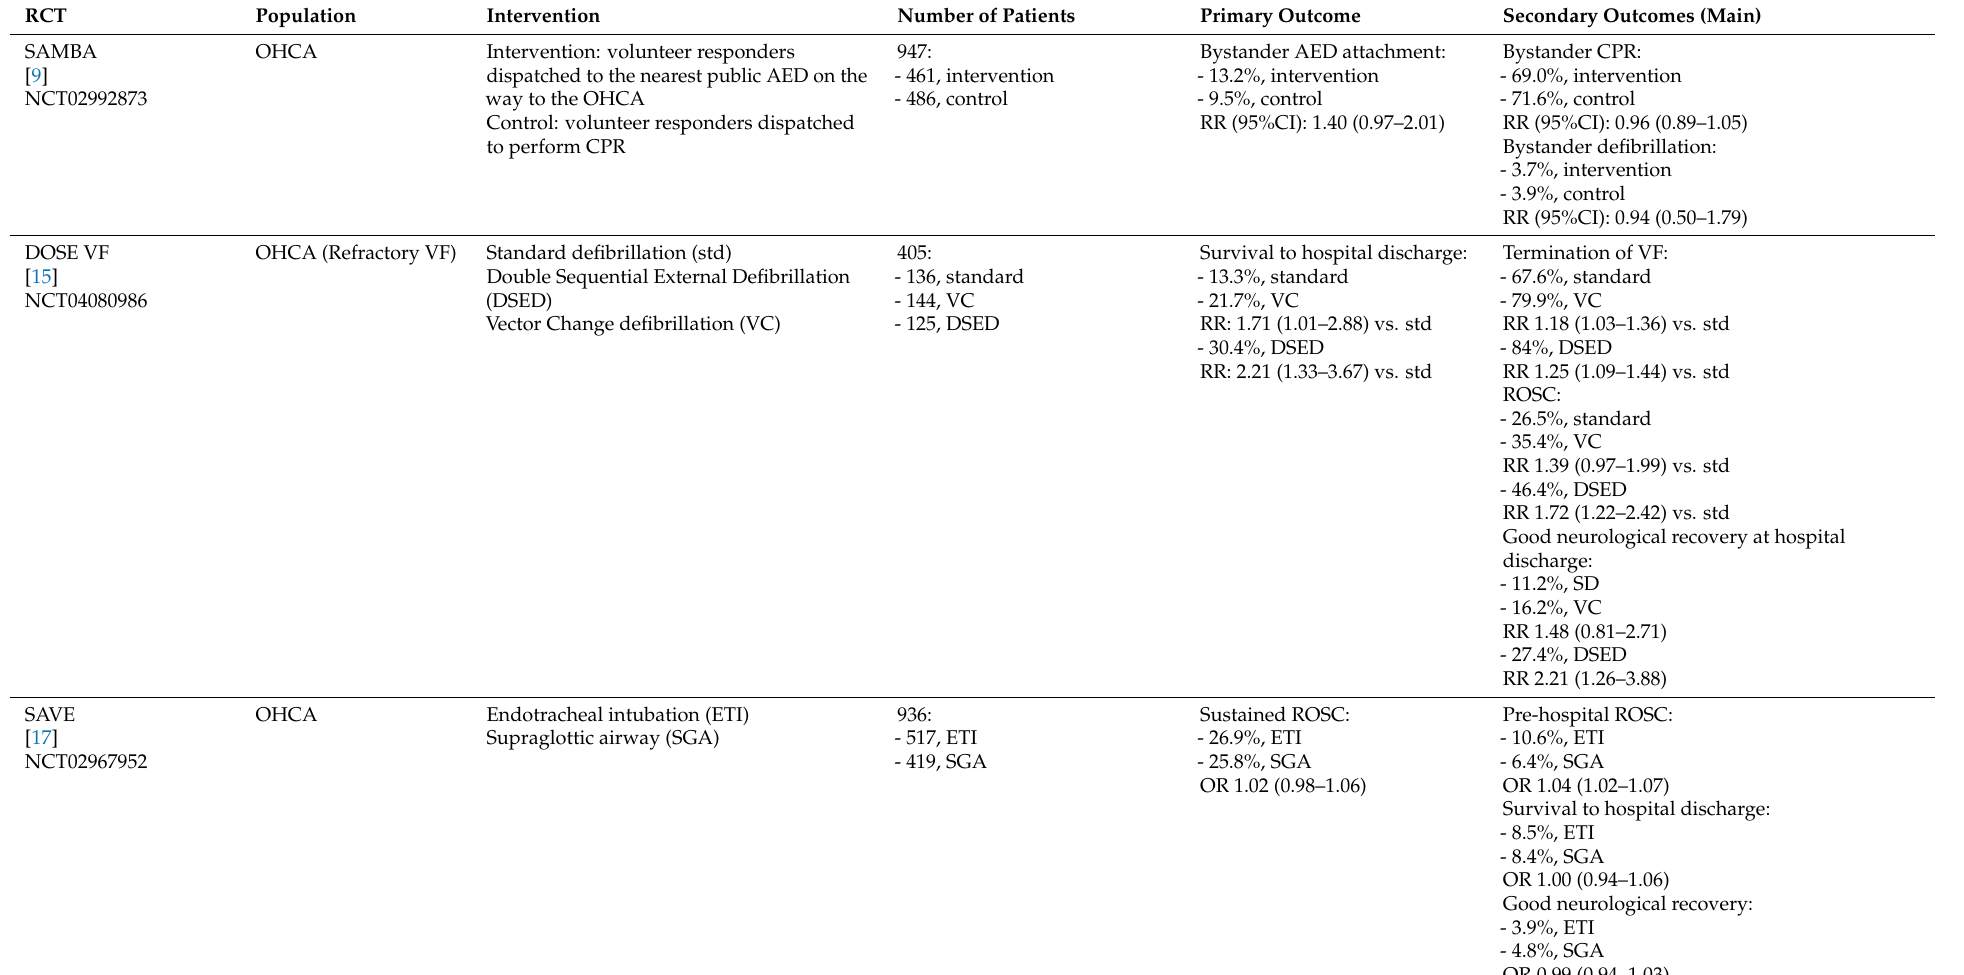
Table 1. Main characteristics of RCTs published in